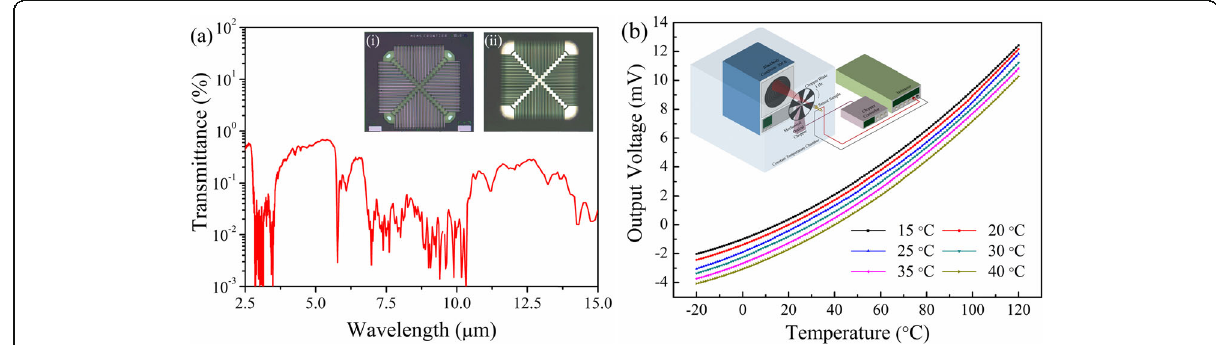
Fig. 9 a Spectral response of thermopile detector. Inset is optical micrographs of the (i) front-side and (ii) backside of the thermopile chip. b Thermoelectric characteristics of thermopile detector at different ambient temperatures. Inset is the schematic diagram of measurement